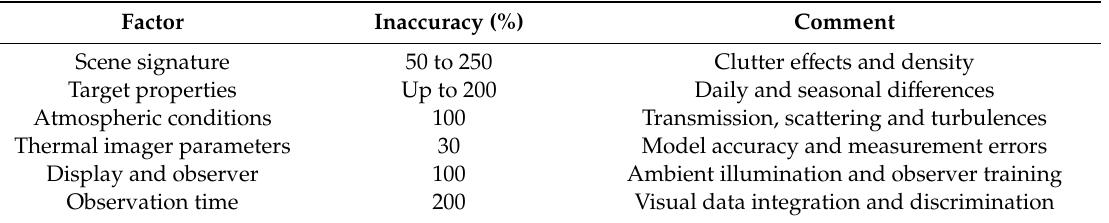
Figure 5. Commonly used test target patterns: ( a ) following D, R, I visual perception criteria; ( b ) illustration of application on a real target and anticipated image; ( c ) visual perception probability versus relative target spatial frequency. Table 5. Factors contributing to application of visual perception-based range estimation in the